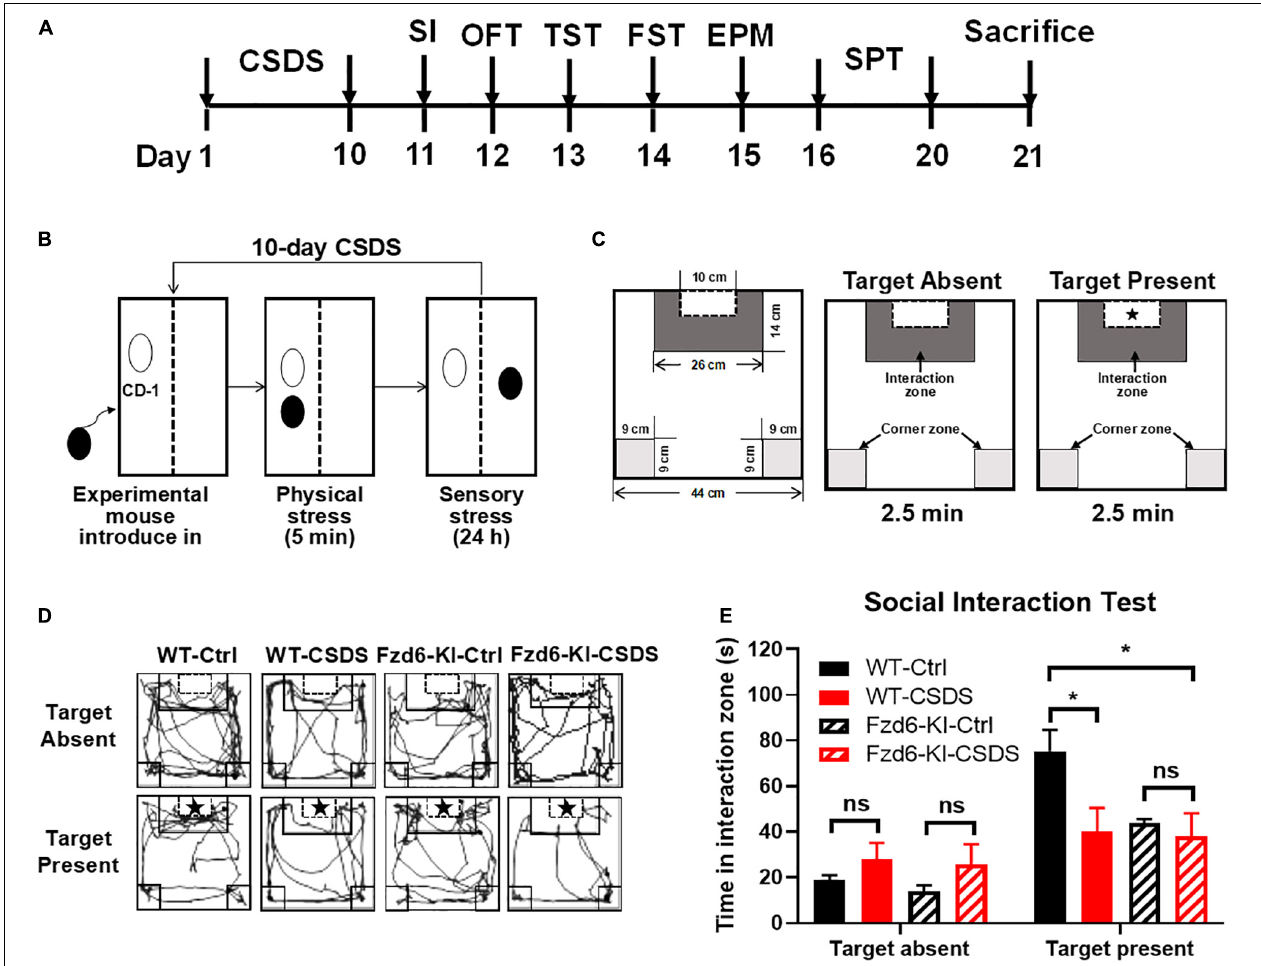
FIGURE 3 | Construction of 10-day CSDS depressive model in Fzd6 -knockin ( Fzd6 -KI) mice. (A) Schematic diagram of experimental design. (B) Schematic of 10-day CSDS model. (C) Schematic of open field arena and zones for social interaction (SI) test in absence or presence of target CD-1 mice. Pentagram marks target mice. (D) Representative tracking plot of SI test in absence (top line) and presence (bottom line) of target. (E) Time spent in interaction zone in absence and presence of target in both wild-type and Fzd6 -KI mice after CSDS. * p < 0.05, ns, not